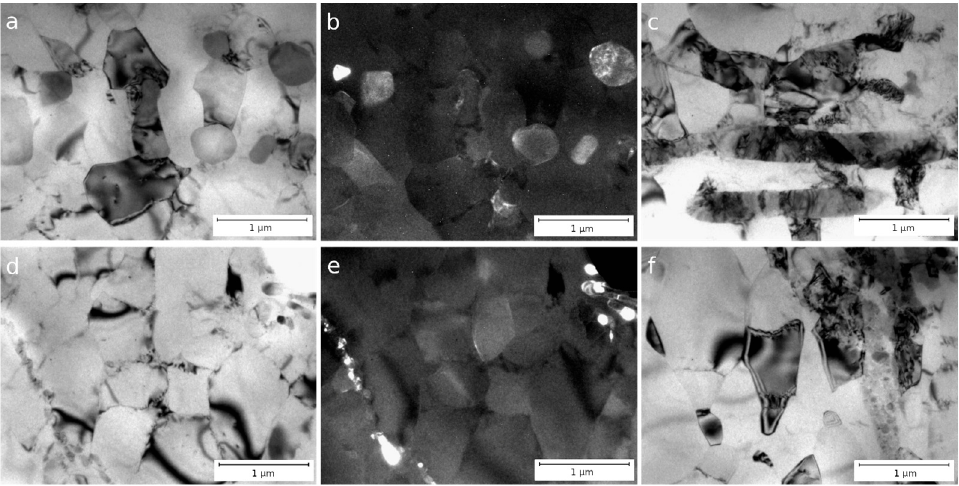
Figure 4. Microstructure of Al–1.7Fe alloys after ECAP: ( a – c ) CC and ( d – f ) EMC, longitudinal section, TEM.